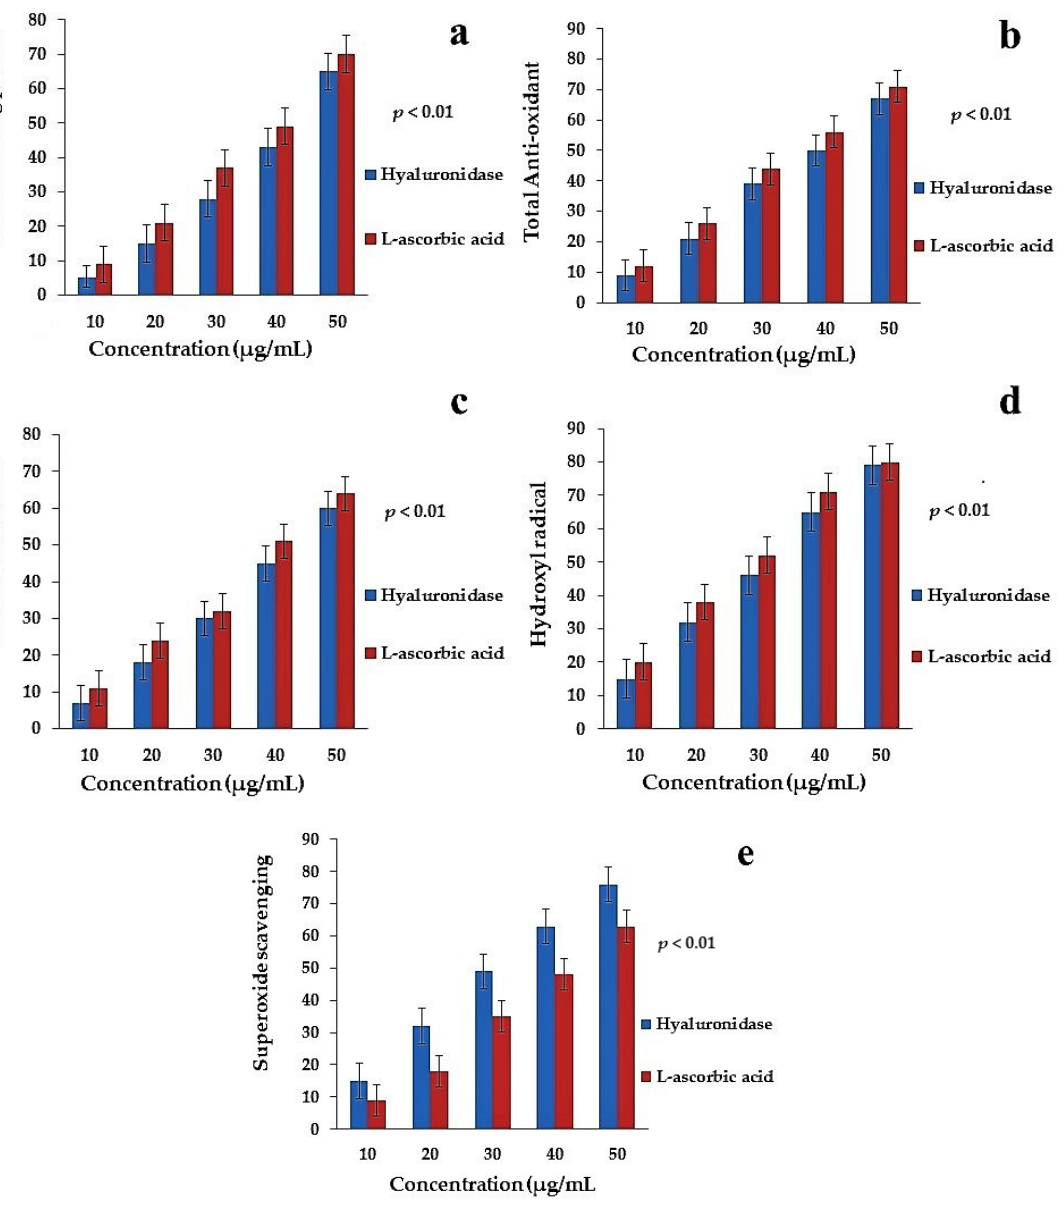
Figure 8. Antioxidant activity in different concentrations of hyaluronidase from CASMTK1, ( a ) reducing power, ( b ) total antioxidant, ( c ) DPPH scavenging, ( d ) Hydroxy radicals scavenging, ( e ) Superoxide scavenging.